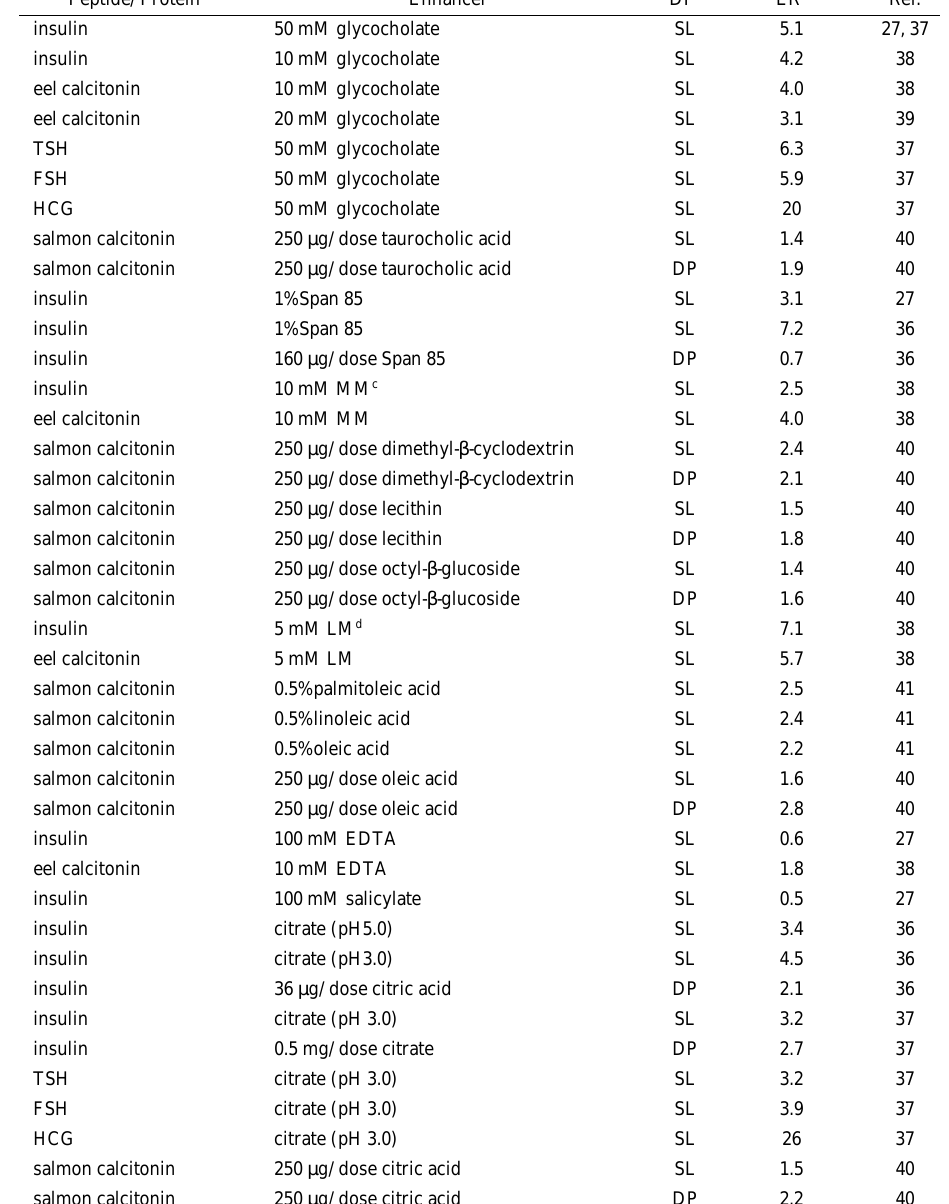
Table 1 Effect of absorption enhancers on pulmonary absorption of peptides and